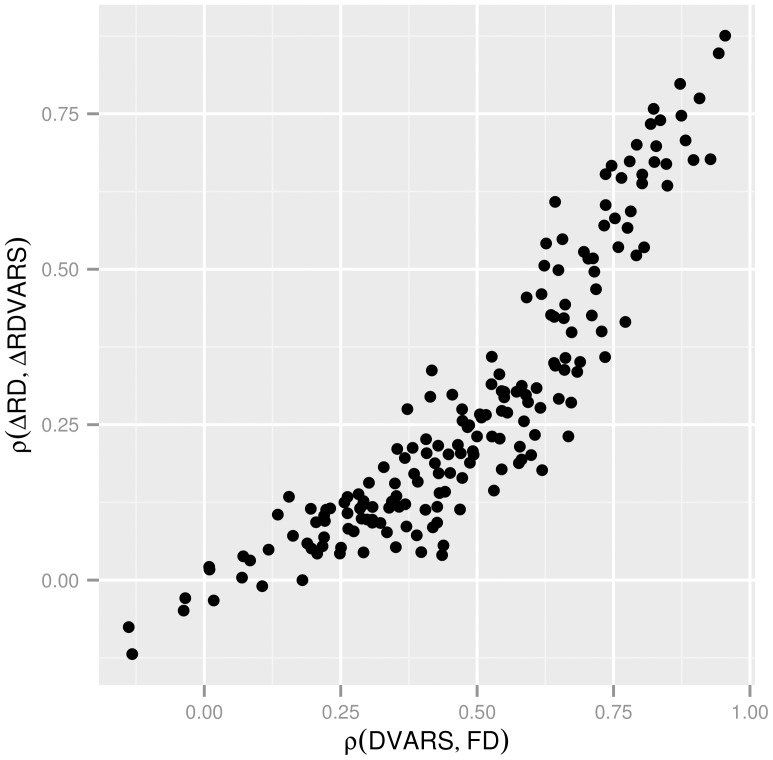
Regional motion-BOLD relationship scales with the global motion-BOLD relationship.Within-subject correlation of  and  (horizontal axis) plotted against the correlation of FD and DVARS (vertical axis) for all brain regions and time frames of N = 183 subjects. The regional effect of motion on BOLD seems to scale with the global relationship which is correlated ( (p<0.000001) with the mean FD.